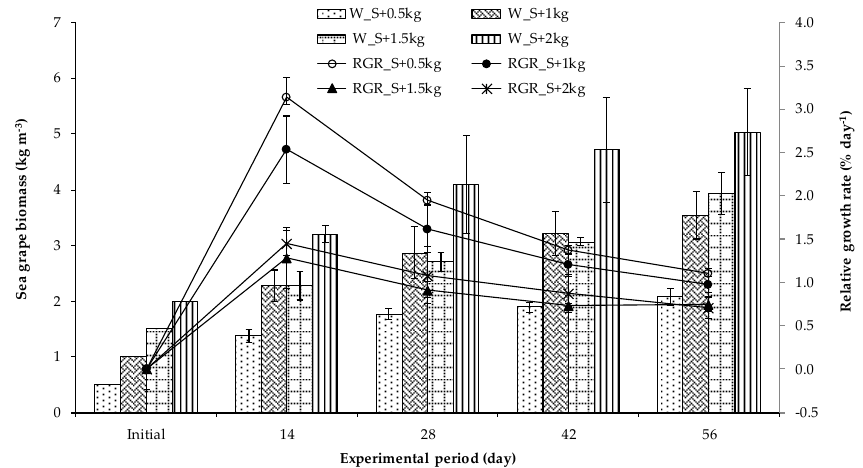
Figure 4. Change in biomass of sea grape co-cultured with shrimp during the experimental duration. The error bars stand for the mean values and standard deviation.